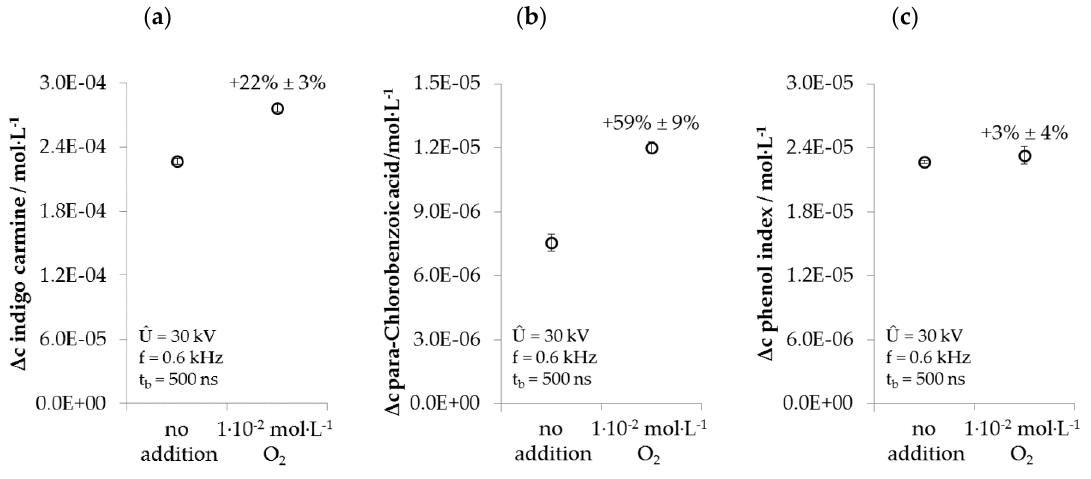
Figure7. Decreaseof( a )indigocarmine, ( b )para-Chlorobenzoicacid, and( c Figure 7. Decrease of ( a ) indigo carmine, ( b ) para-Chlorobenzoic acid, and ( c ) phenol index concentration ( Δ c ) without and with the addition of 1 × 10 − 2 mol ∙ L − 1 of oxygen in the process water.